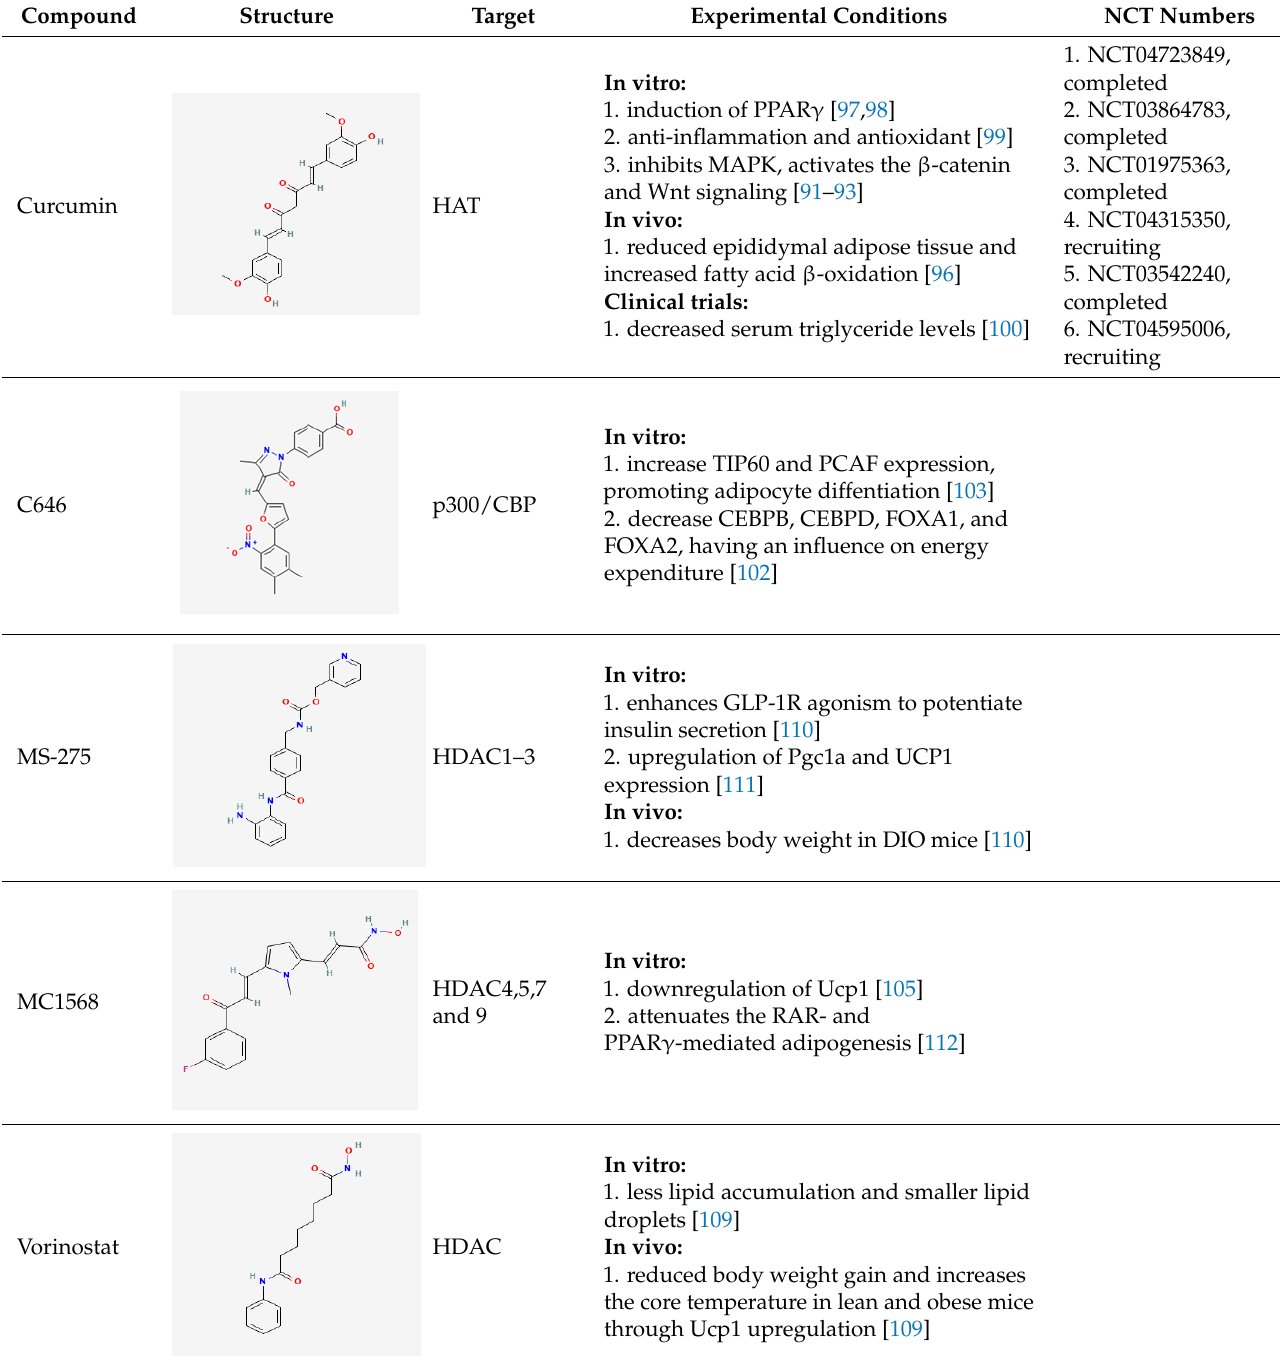
Table 2. Compounds modulating the epigenetic regulation of adipogenesis.